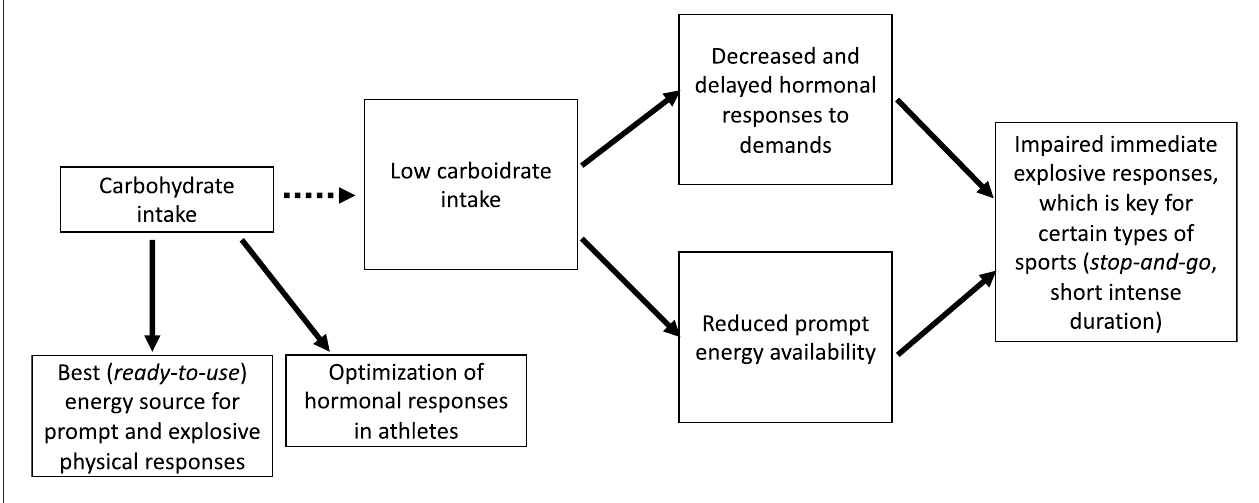
FIGURE 4 | Proposed mechanisms for the impaired performance observed in prolonged low carbohydrate